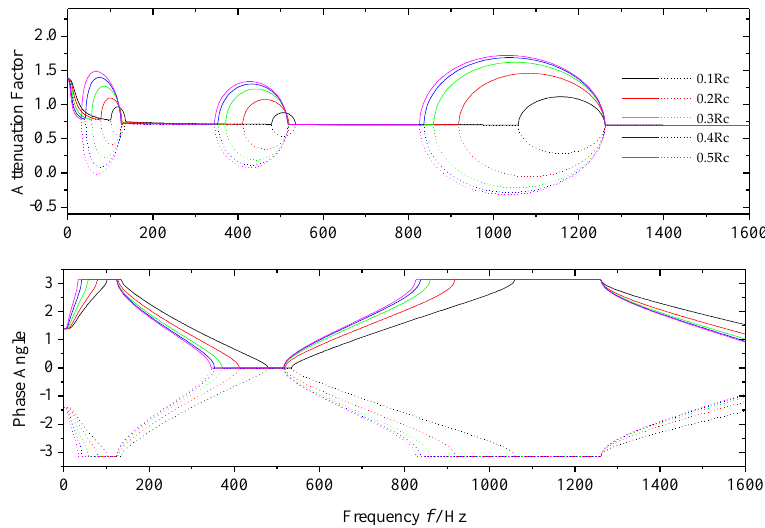
Figure 10. Numerical propagation constants derived from different crack depths.